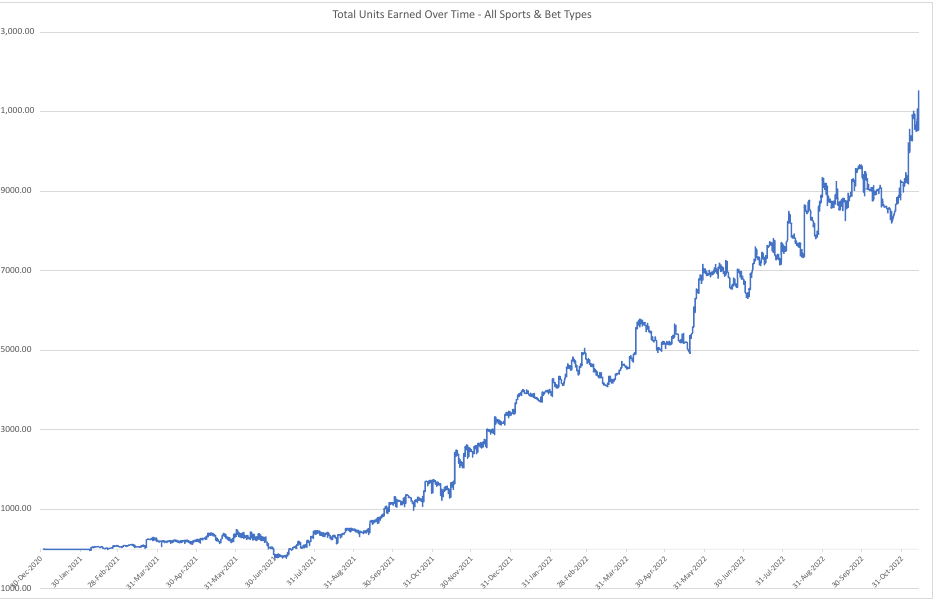
Figure 13. Total units earned over time for all sports tested on, moneyline and spread bets, 1 January 2021 through 15 November 2022.